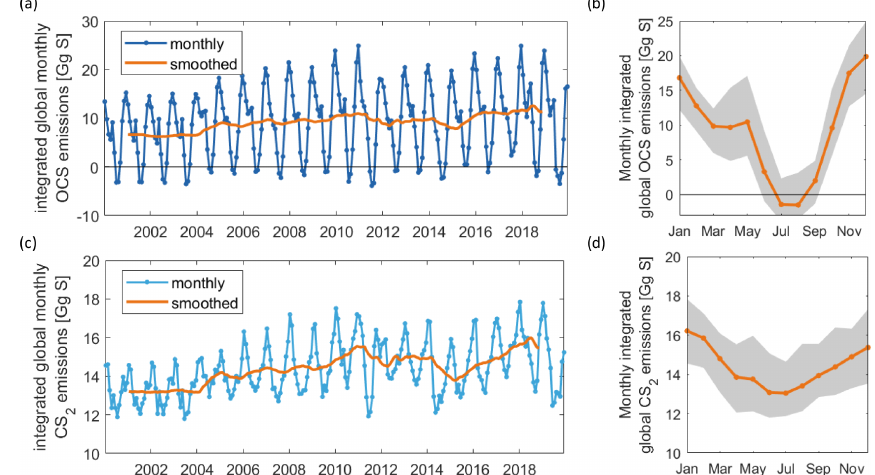
Figure 3. Interannual variability in OCS emissions as time series (a) and mean annual cycle in orange, standard deviation of respective month in the shaded grey area (b) . Panels (c) and (d) are the same as (a) and (b) but for CS 2 . The model output is saved in 2h intervals for the 15th of each month and integrated over 30d for the monthly emissions shown here.